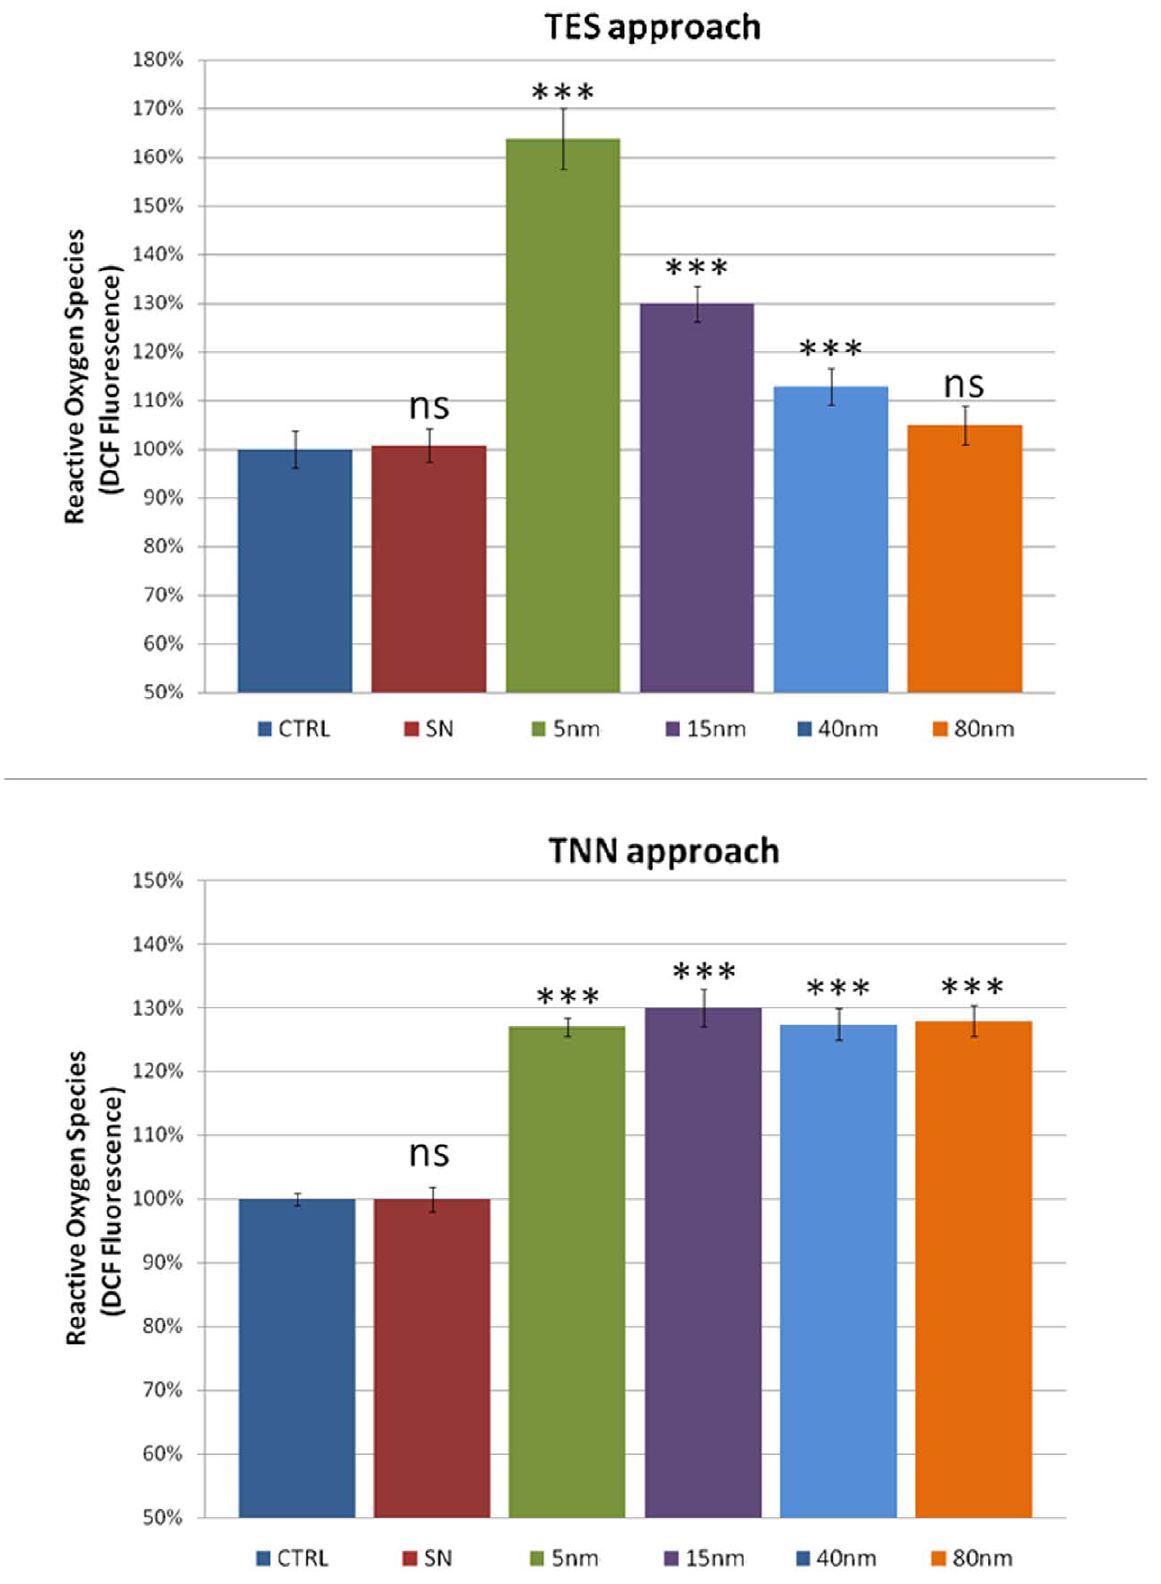
Figure 3. ROS measurements by DCF assay on TES and TNN treatments (top and bottom, respectively). Data are reported as relative fluorescence intensity normalized to the control (ns = non significant, i.e. p-value . 0.05; ***p-value , 0.001). Error bars = SD.